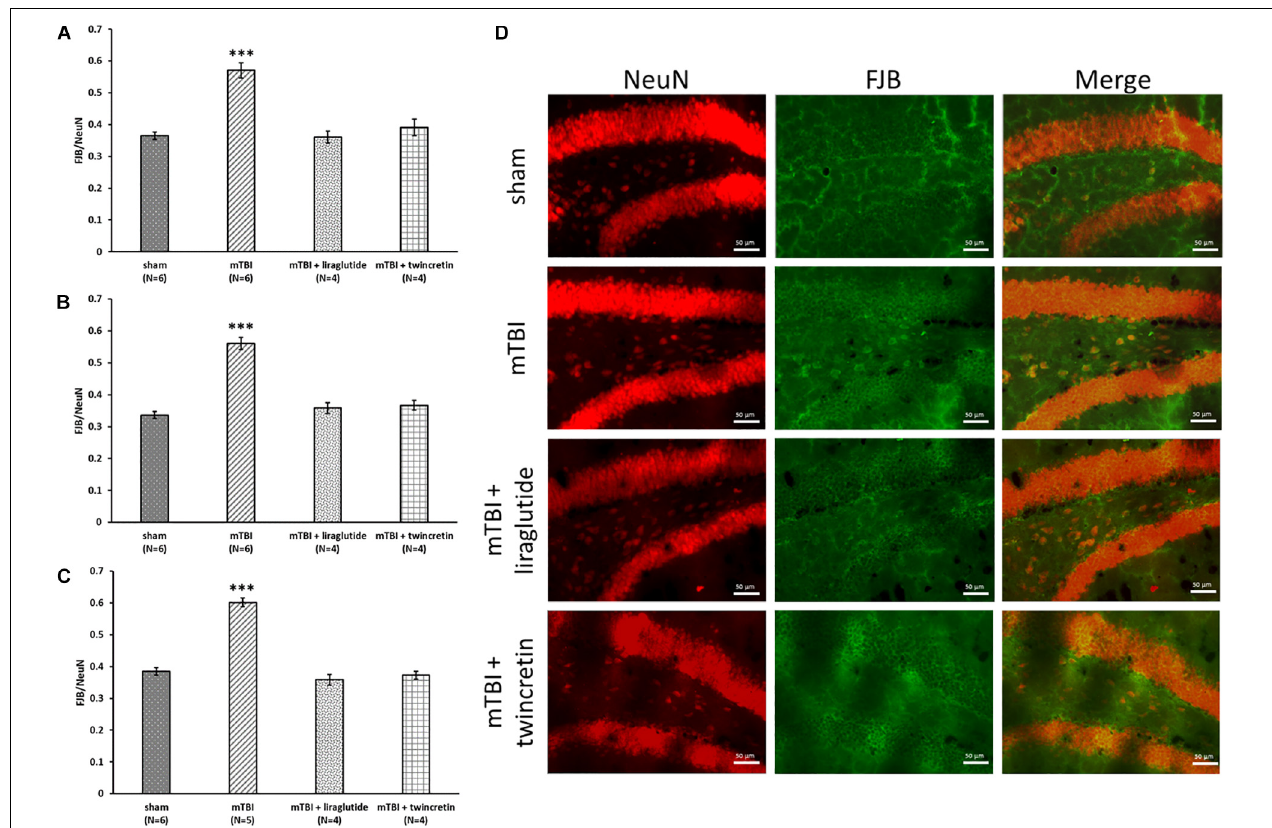
FIGURE 4 | Liraglutide and twincretin treatments mitigate mTBI-induced neurodegeneration, 72 h post trauma. Graphs showing the quantification of degenerating neurons as the ratio of FJB/NeuN in the temporal cortex (A) , CA3 region (B) , and the dentate gyrus (C) . One-way ANOVA test followed by Fisher’s LSD post hoc analysis demonstrated that mTBI induction led to significant elevation in the ratio of degenerating neurons compared to sham tissues in all regions tested [ A: F (3,16) = 26.695; p < 0.001, B: F (3,16) = 48.130; p < 0.001, and C: F (3,15) = 73.021; p < 0.001, ∗∗∗ p < 0.001]. Treatment with either liraglutide or twincretin caused a significantly lower FJB/NeuN ratio compared to mTBI ( ∗∗∗ p < 0.001), suggesting a reduction in the development of neurodegeneration following the injury. Values are mean ± SEM. (D) Representative images of immunohistochemical staining in the dentate gyrus are presented. NeuN positive cells are shown in red and FJB positive cells are shown in green; merged images show the overlap of FJB/NeuN positive cells. The scale bars are 50 µ